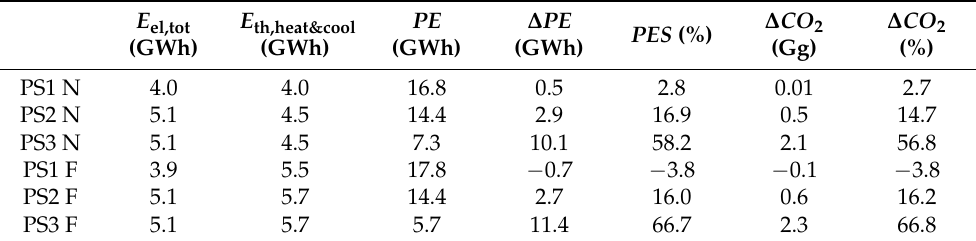
Table 10. Annual energetic results of the proposed systems for the districts located in Naples and Fayoum. ∆ PE E el,tot E th,heat&cool PE (GWh) (GWh) (GWh) (GWh)